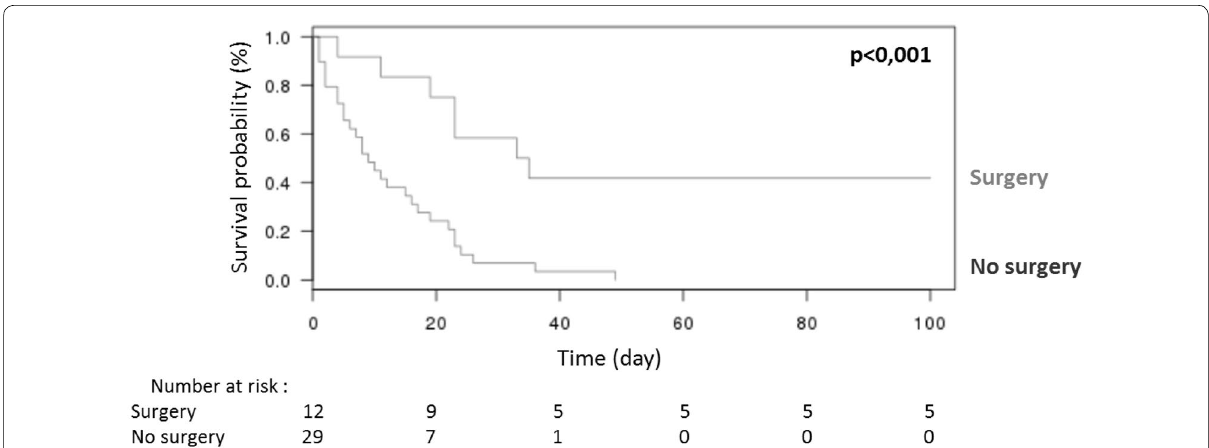
Fig. 1 Zygomycosis survival in the subgroup of patients with hematological malignancies: comparison between those who benefited from surgery (Surgery) and those who did not (no Surgery), with number of patients at